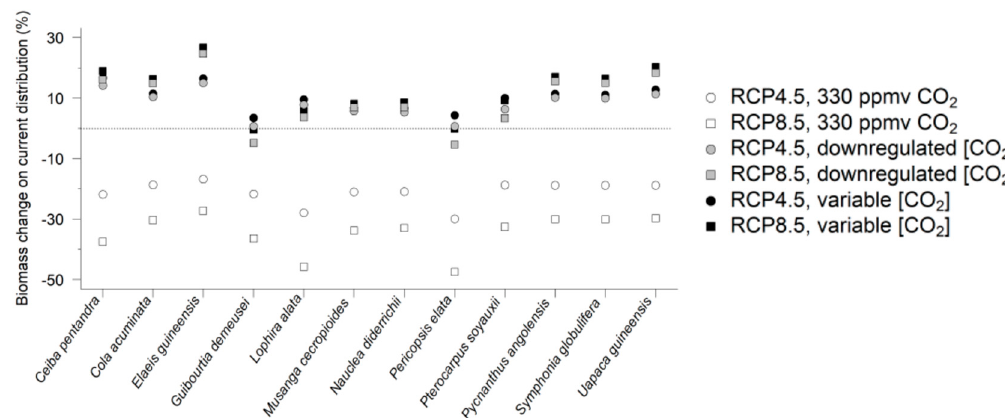
Figure 7. Species biomass change on current distribution between the 2080–2099 period and the reference 1980–1999 period. The values correspond to the ensemble mean of the results obtained with the seven climate projections under the RCP4.5 (squares) and RCP8.5 (circles) scenarios, and three CO 2 configurations assuming respectively a CO 2 constant [330] (white), a CO 2 variable downregulated [down] (grey) and a CO 2 variable [var] (black), and species-specific morpho-physiological